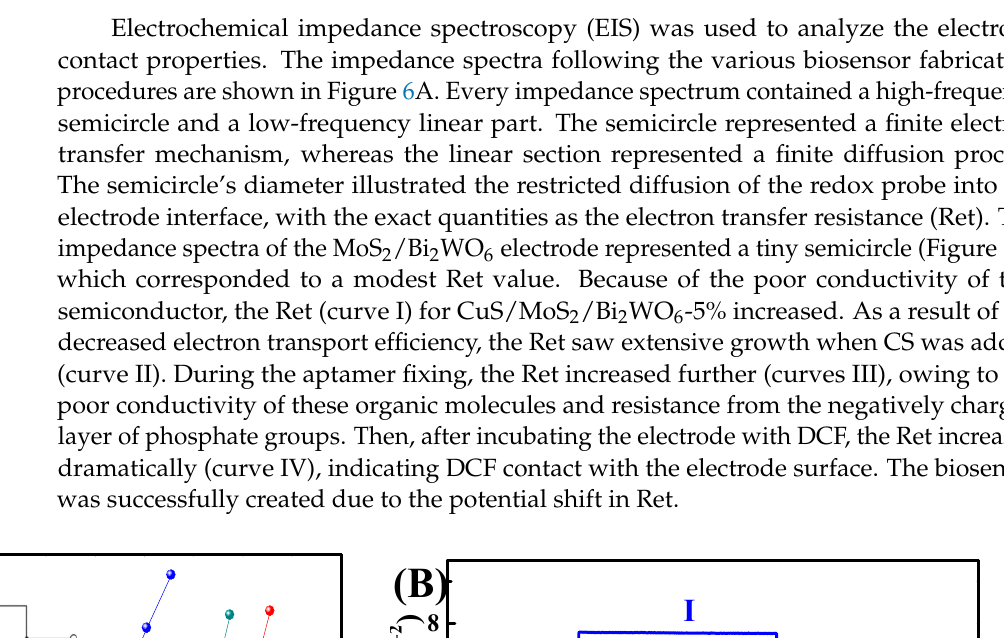
Figure 5. Band structures for ( A ) Bi 2 WO 6 and ( B ) CuS/MoS 2 /Bi 2 WO 6 and DOS for ( C ) Bi 2 WO 6 and ( D ) CuS/MoS 2 /Bi 2 WO 6 − 5%.